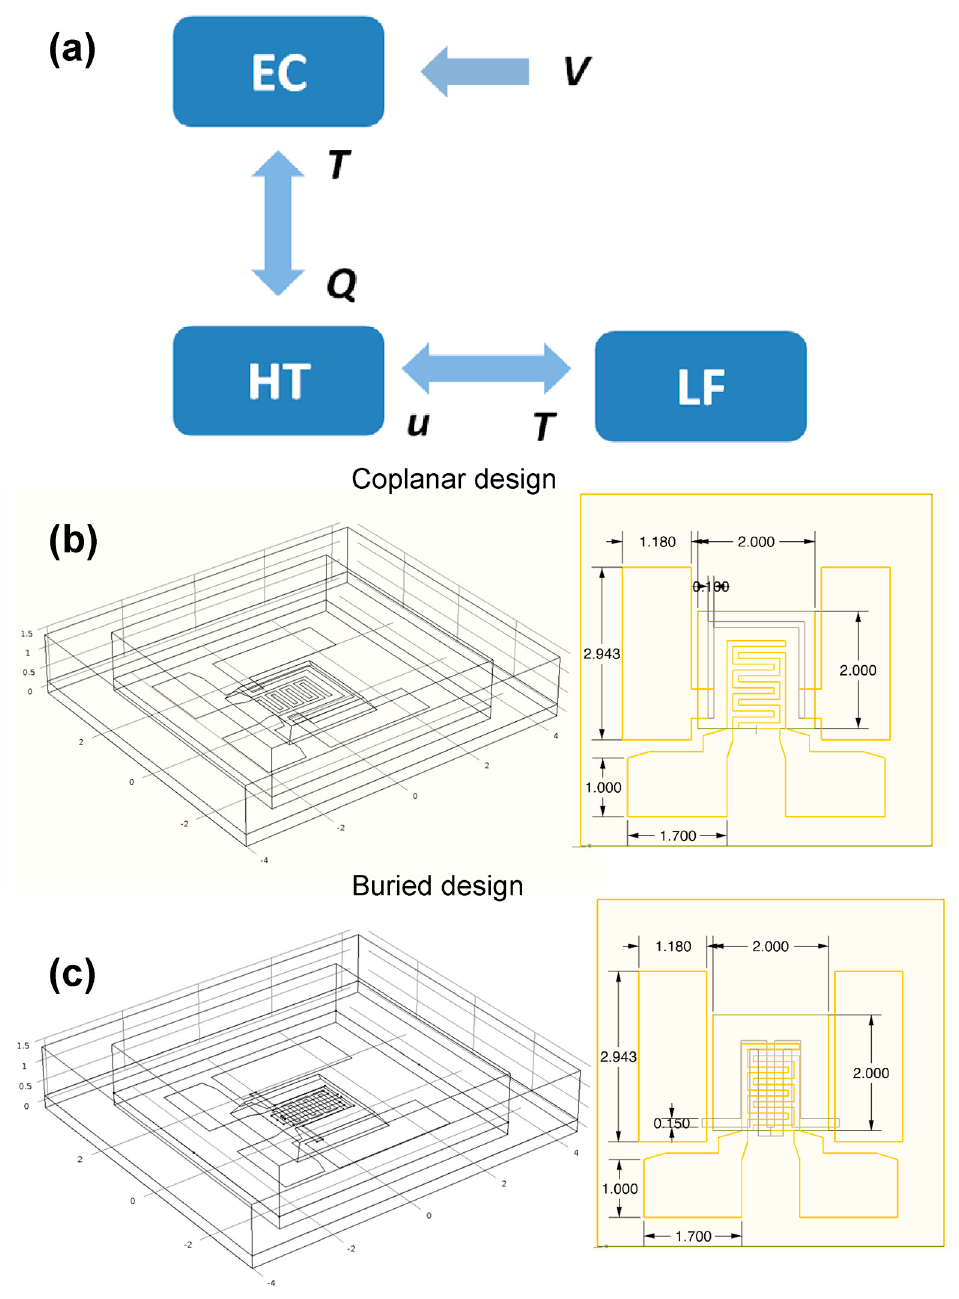
Figure 2. ( a ) Schematic correlation between the equations involved in multiphysics and ( b ) 3D geometries for the coplanar and ( c ) buried models. In the insets the 2D sketches show the exact quotes of the device layout. All the quotes are in mm.